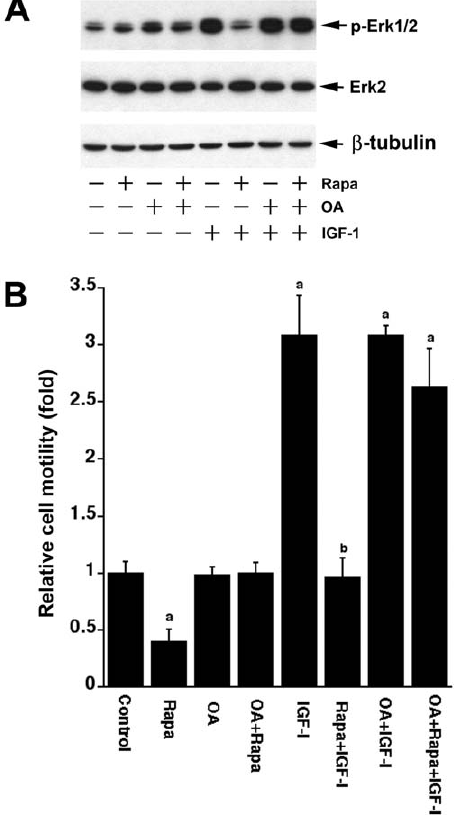
Figure 3. Inhibition of PP2A with okadaic acid confers resistance to rapamycin inhibition of IGF-1-induced phosphor- ylation of Erk1/2 and cell motility. (A) Serum-starved Rh1 cells were pretreated treated with or without OA (100 nM) for 1 h, and then treated with or without rapamycin (Rapa, 100 ng/ml) for 2 h, followed by stimulation with or without IGF-1 (10 ng/ml) for 15 min. Cell lysates were analyzed by Western blotting using indicated antibodies. b -tubulin served as loading control. (B) Motility of Rh1 cells was determined by the wound healing assay, as described in Materials and Methods . Following wounding, serum-starved Rh1 cells were pretreated treated with or without OA (100 nM) for 1 h, and then treated with or without rapamycin (Rapa, 100 ng/ml) for 2 h, followed by stimulation with or without IGF-1 (10 ng/ml) for 22 h. Cells migrated over the denuded area were observed and photographed with an Olympus inverted phase- contrast microscope equipped with Quick Imaging system. The number of cells migrating per millimeter of scratch was counted. Results are means 6 SE of 3–4 independent experiments. a P , 0.05, difference vs. control group; b P , 0.05, difference vs. IGF-1